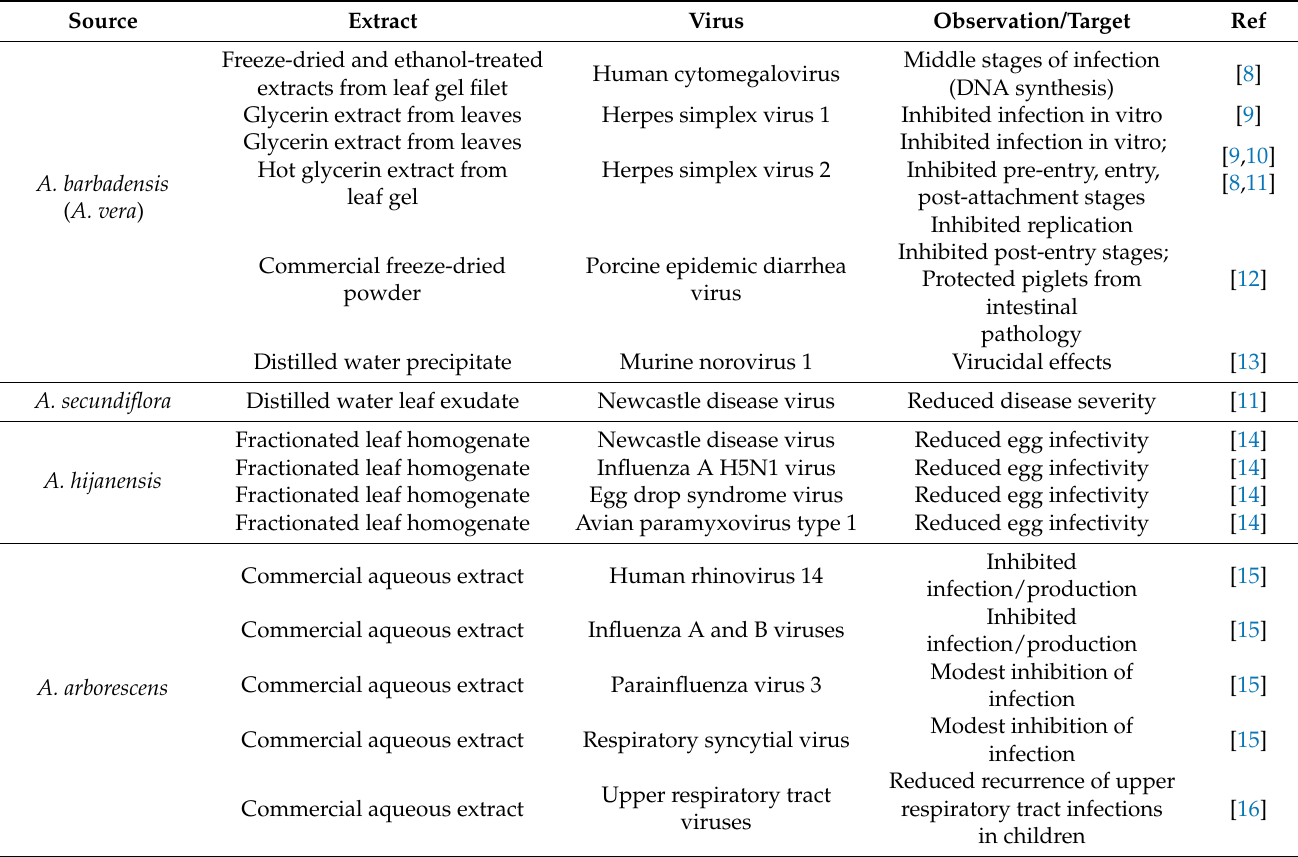
Table 1. Antiviral activities of extracts from Aloe